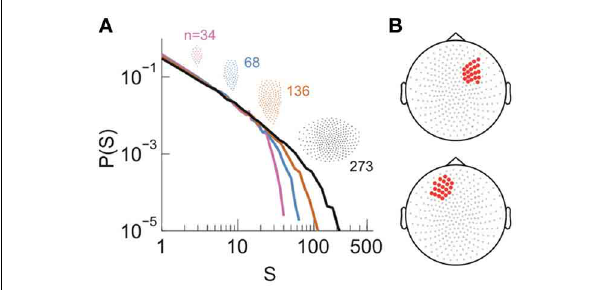
FIGURE 5 | Power law size distribution of neuronal avalanches recorded with MEG for the human brain at resting state. (A) Neuronal avalanche dynamics are identified when the sizes ( s ) of all clusters distribute according to a power law with slope close of − 1.5 (the results for subject 2 are shown here). Four distributions from the same original data set using different areas (insets), i.e., number of MEG sensors ( n ), are superimposed. (B) The whole array of sensors (gray dots) and two sub-groups of sensors that were used for finite-scaling analysis (red